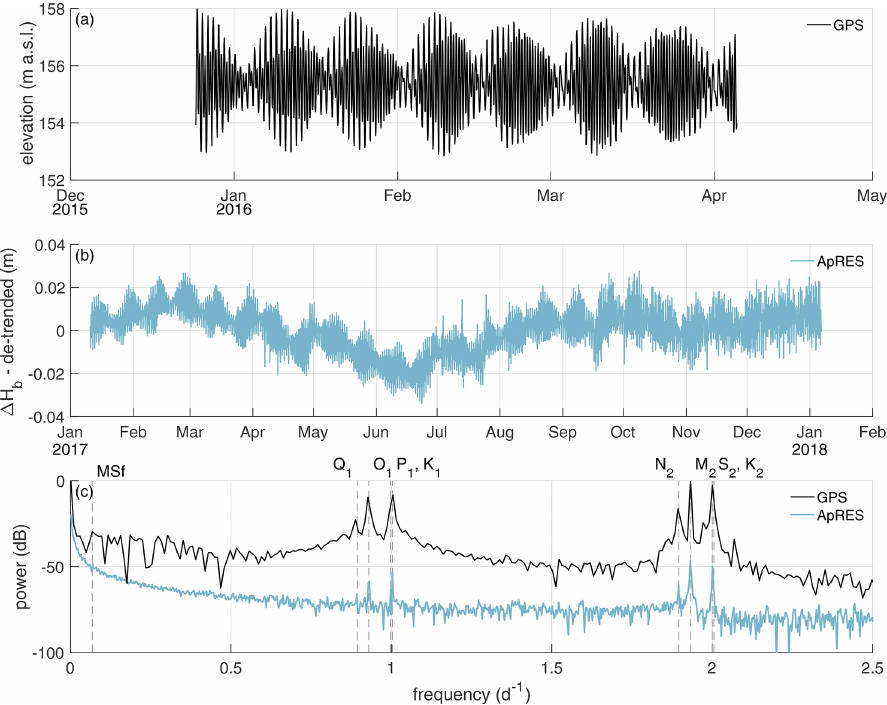
Figure A5. (a) Surface elevation recorded by the GPS station from the end of December 2015 to early April 2016. (b) Linear de-trended cumulative melt ( (cid:49)H b ) from ApRES observations between January 2017 and January 2018. (c) Frequency spectrum from data shown in panels (a) and (b) . Vertical gray dashed lines mark the constituents with half-day periods ( N 2 = 12 . 66h, M 2 = 12 . 42h, S 2 = 12 . 00h, K 2 = 11 . 97h), daily periods ( Q 1 = 26 . 87h, O 1 = 25 . 82h, P 1 = 24 . 07h, K 1 = 23 . 93h) and fortnightly period (MSf = 14 . 76d).